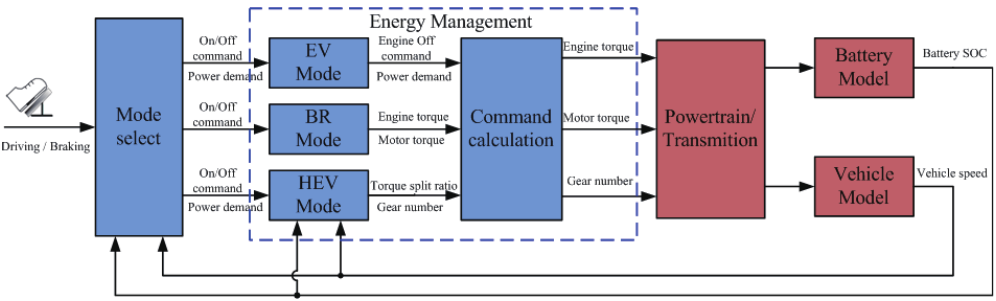
Figure 2. Schematic diagram of the vehicle control